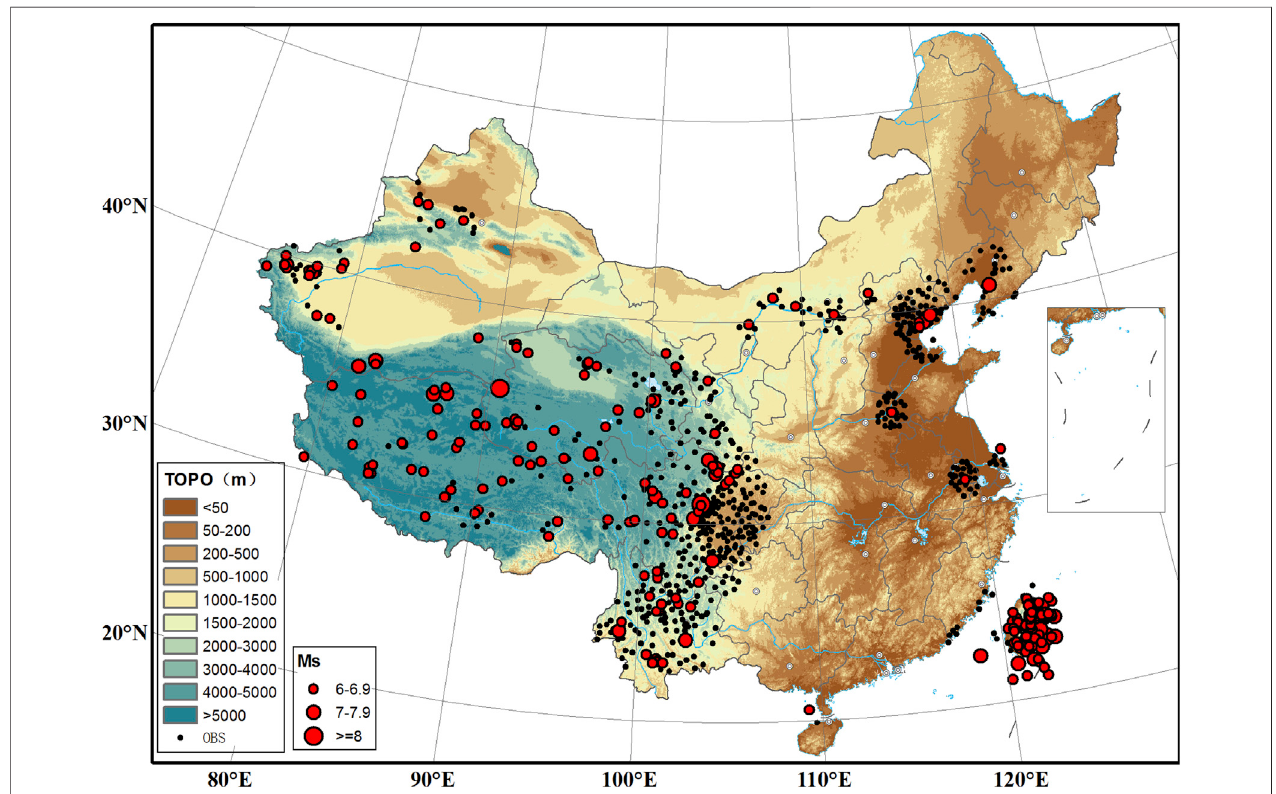
FIGURE 2 | Spatial distribution of strong earthquakes (M s ≥ 6.0; red dots) and the corresponding meteorological stations (black dots) in China.